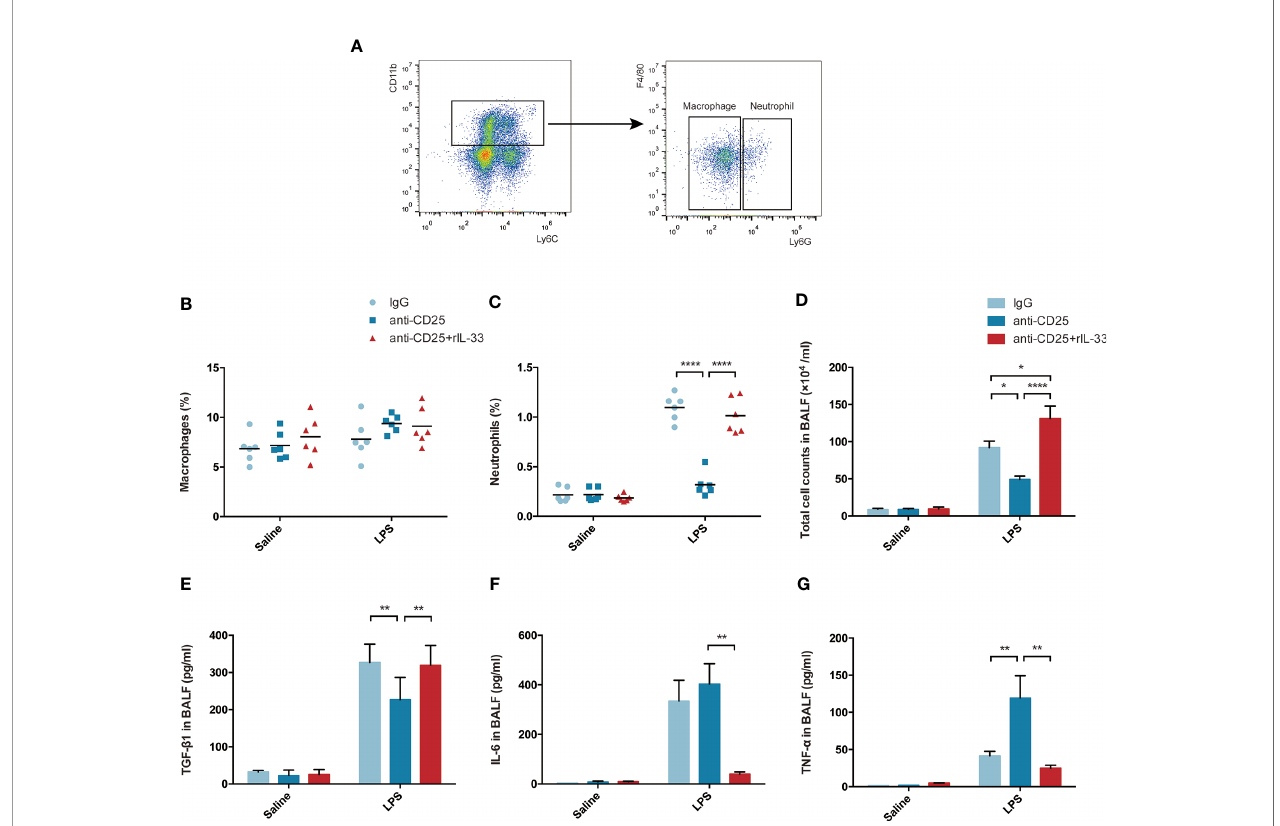
FIGURE 9 | IL-33-dependent accumulation of Treg cells might mediates pulmonary regeneration during LPS-induced ARDS via TGF- b 1 signaling. (A – C) Exogenous IL-33 supplementation did not affect the macrophages, but interfere with neutrophils population in Treg depleted mice after LPS. (A) Schematic sorting of macrophages (CD11b+Ly6c+F4/80+Ly6G − ) or neutrophils (CD11b+Ly6c+F4/80 − Ly6G+) in the lung suspension. The percentage of (B) macrophages or (C) neutrophils in the lung was detected by fl ow cytometry. (D) Total cell counts in BALF were evaluated by a hemocytometer. (E) Secretion of cytokine TGF- b 1 in BALF. (F) Secretion of cytokine IL-6 in BALF. (G) Secretion of cytokine TNF- a in BALF. For all panels: mean ± S.D. *p ≤ 0.05; **p ≤ 0.01; and ****p ≤ 0.0001 for one-way analysis of variance with the Bonferroni post hoc test for multiple t-tests. A value of p < 0.05 was considered statistically signi fi cant. n = 6 mice per